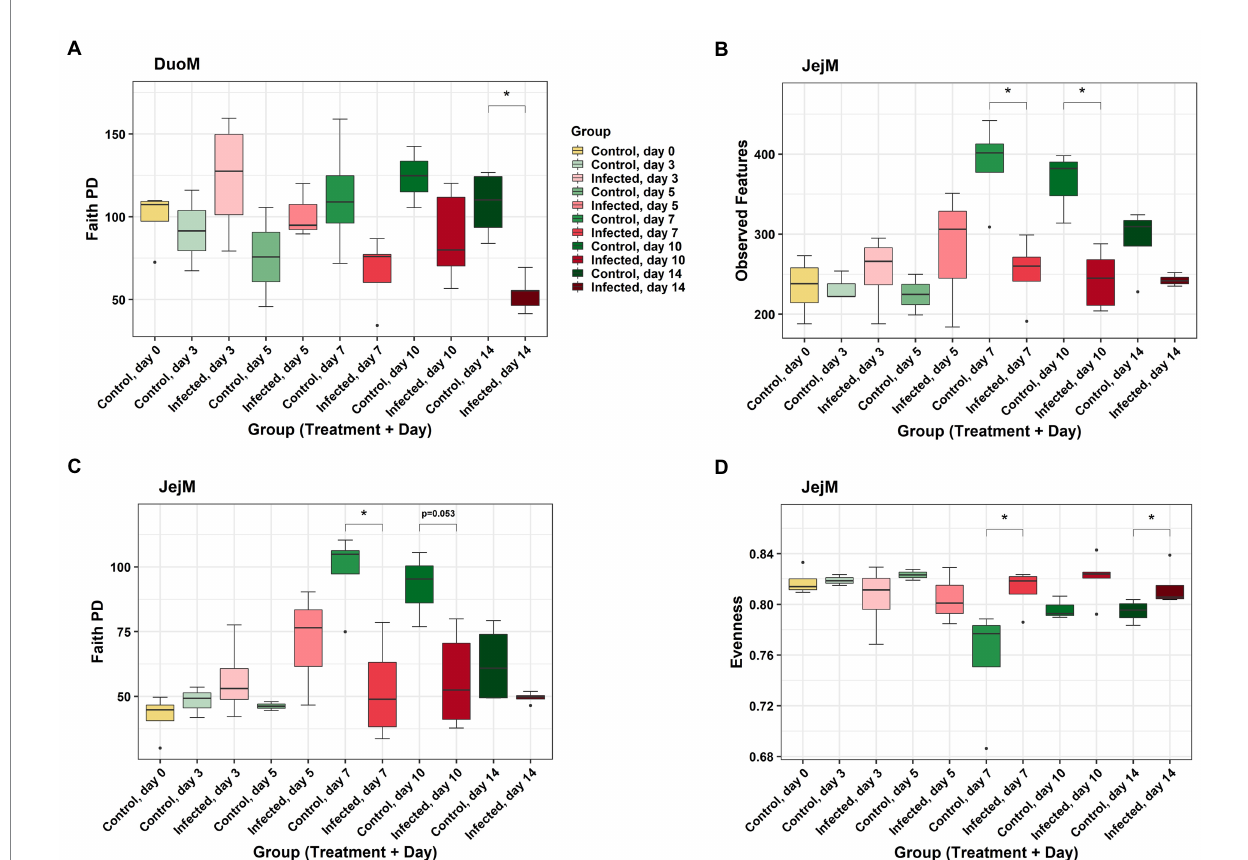
FIGURE 3 Comparisons of alpha diversity metrics between Eimeria acervulina -infected birds and control birds at multiple time points in duodenal mucosal (DuoM) microbiota, (A) Faith’s phylogenetic diversity (Faith PD, richness), and in jejunal mucosal (JejM) microbiota: (B) number of observed features (ASVs), (C) Faith’s phylogenetic diversity (richness), and (D) evenness. Stars (*) denote statistically significant ( p < 0.05) differences between